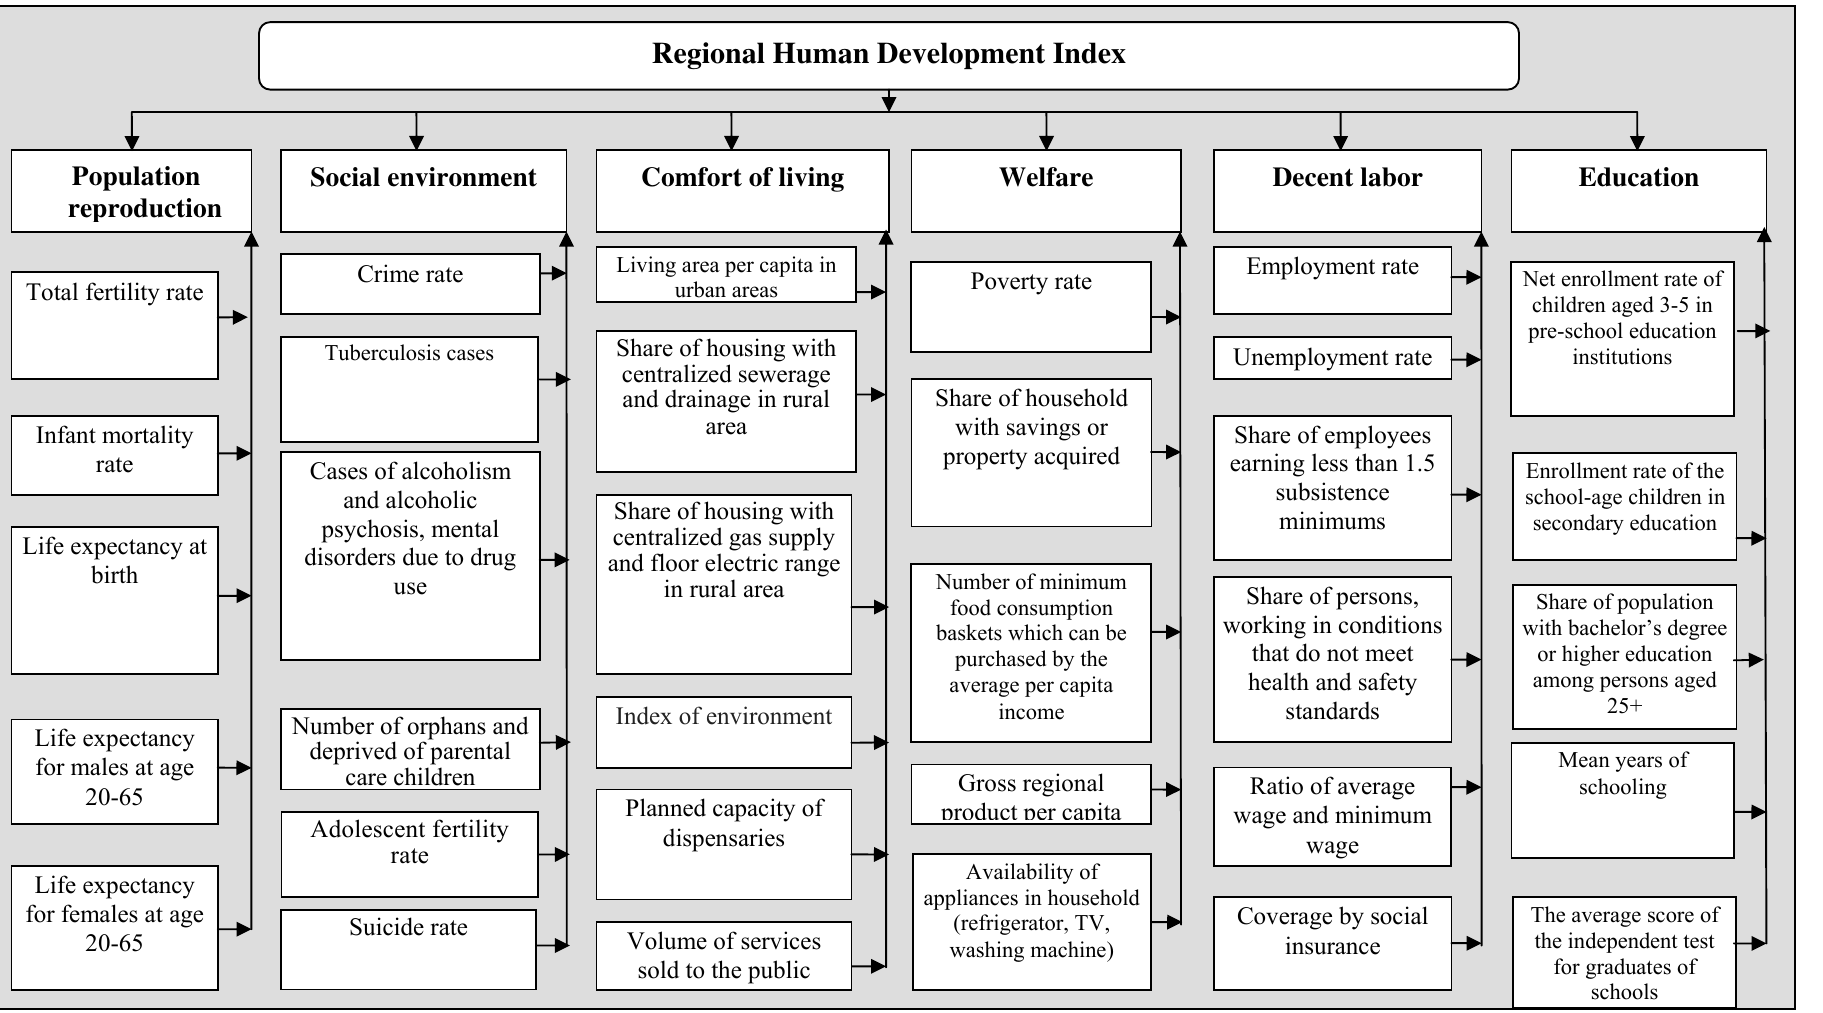
Fig. 1. The system of indicators of regional human development